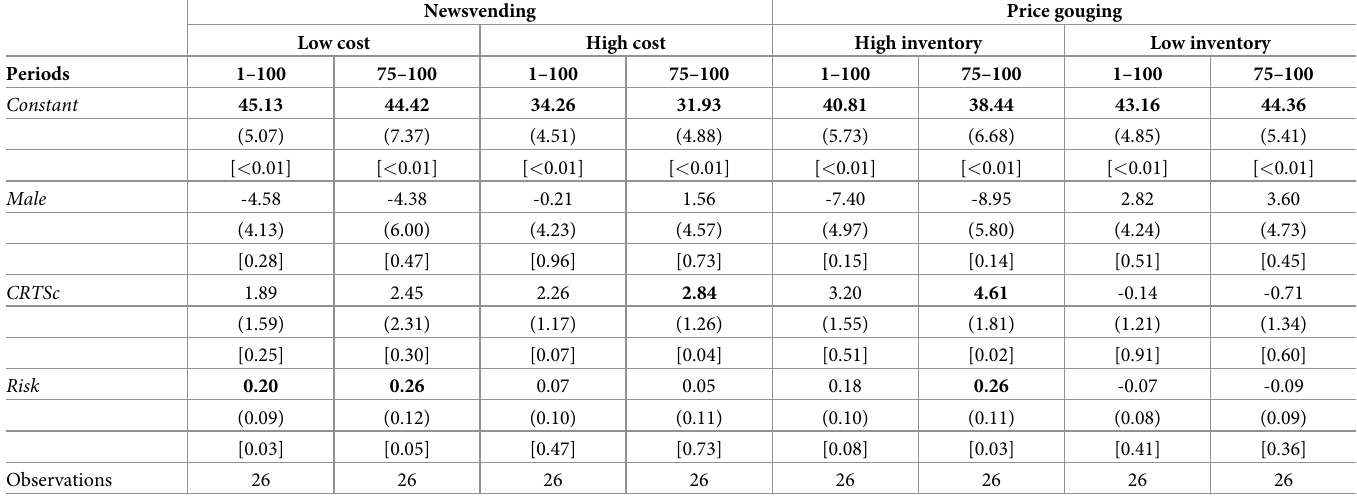
Table 3. Regression analysis of individual characteristics on average